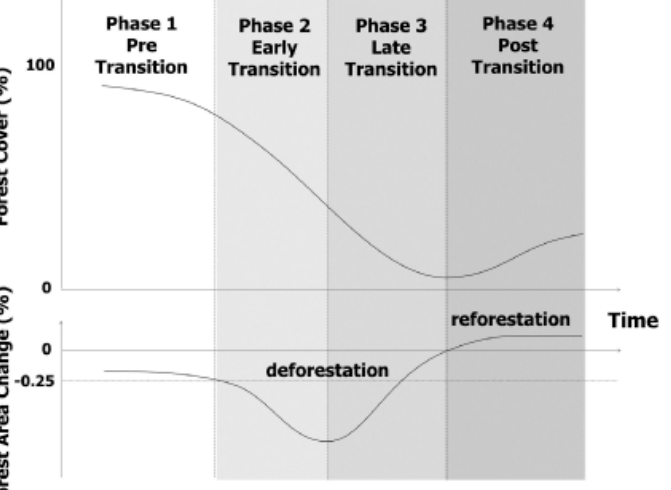
Figure 1. A framework illustrating the Forest Transition Theory (FTT) in advanced economies (Source: authors’ elaboration from Rudel et al., 2005).